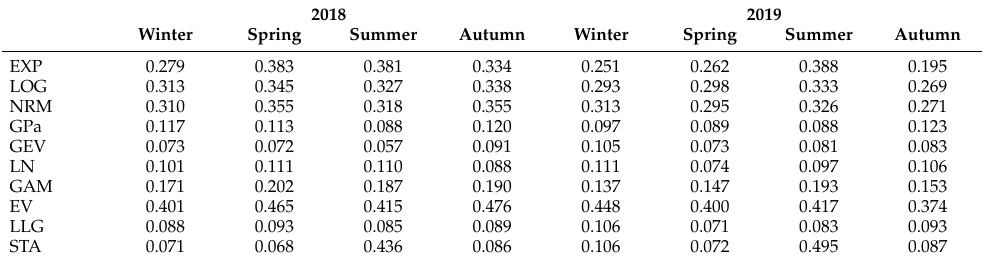
Table 10. KS-distances results for the Maximum likelihood, for the 600 m threshold.